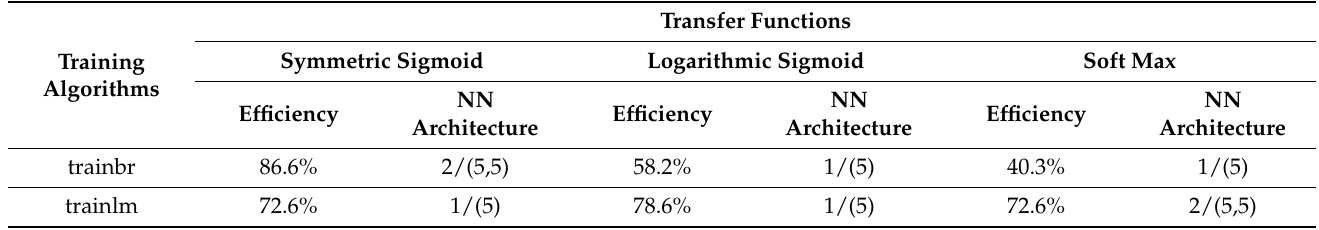
Table 6. Comparisons between the best efficiencies over best NN architecture for the tested training algorithms and transfer